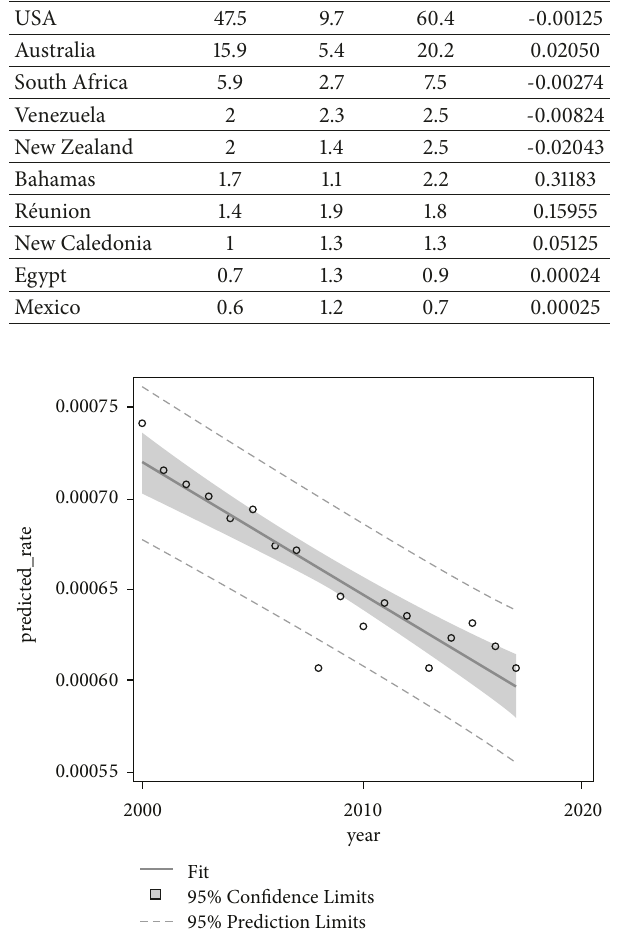
Figure 1: Global model for bite rates between 2000 and 2016.